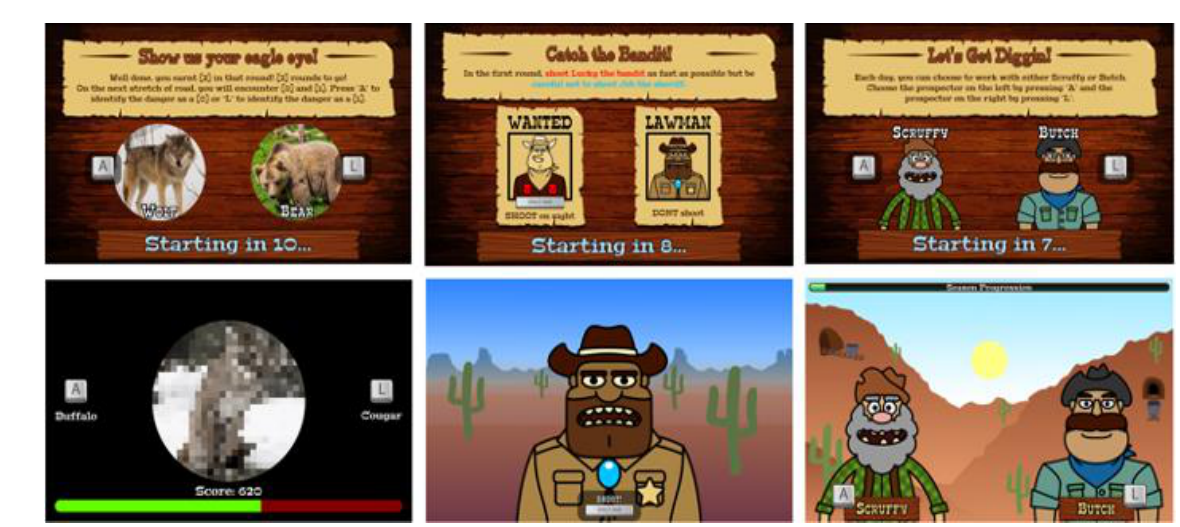
Figure 1. The three tasks from the CIS (from left to right): Caravan Spotter, Bounty Hunter, Prospectors Gamble. Presentation order of task components was counterbalanced across participants. Example trials for each task are represented as short clips on YouTube: https://www.youtube.com/playlist?list=PLs-GMH-Foyaz-UkhauX-uSCDBQkAM1sTv. Access date: 31 May 2018. Figure was adapted from a previous publication from our group [16].